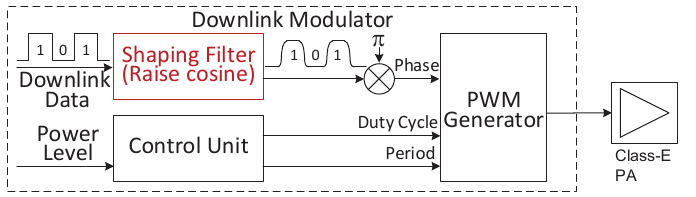
Figure 8. The block diagram of the out-body downlink modulator and a shaping filter is introduced to reduce the phase jump impact of BPSK on Class E